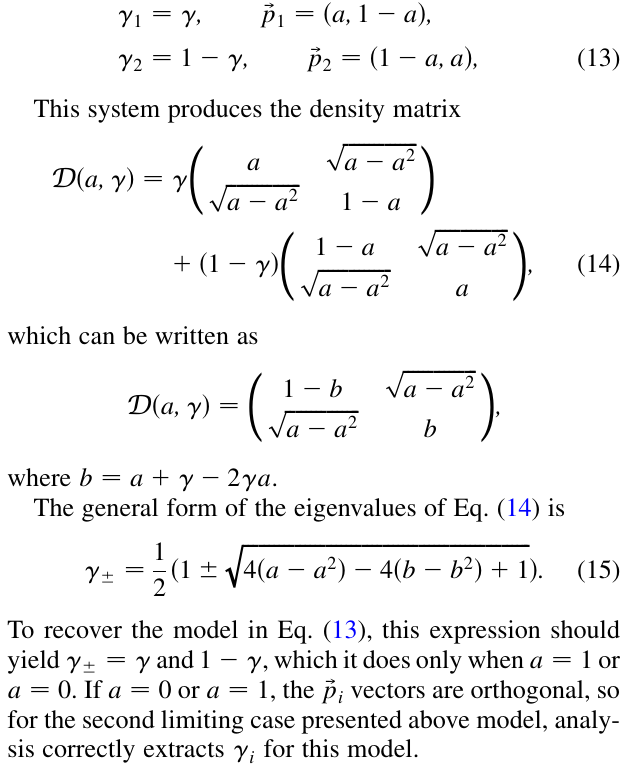
ffiffiffiffiffiffiffiffiffiffiffiffiffiffiffi